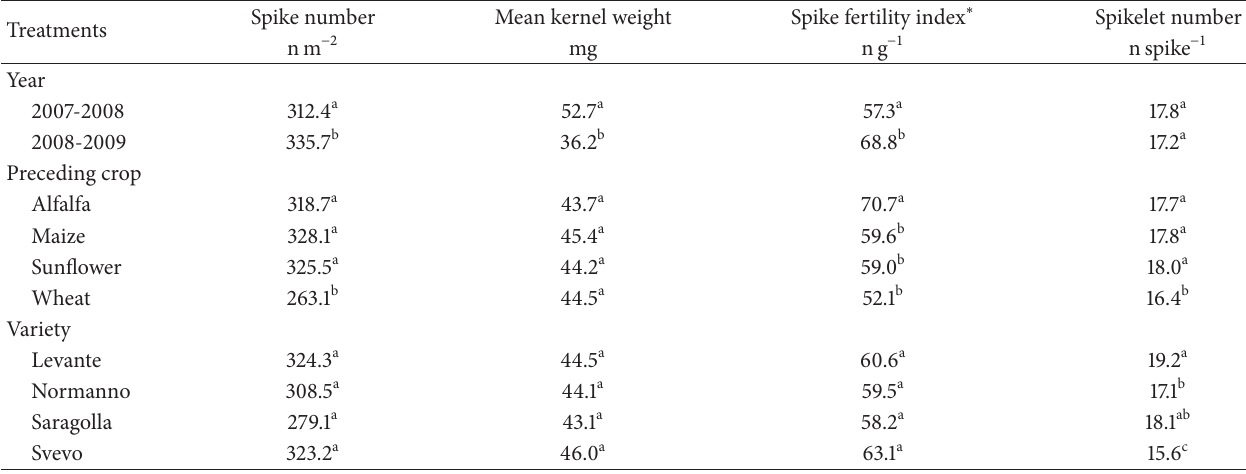
∗ Spike fertility index: grain number m − 2 /spike chaff dry weight m − 2 at